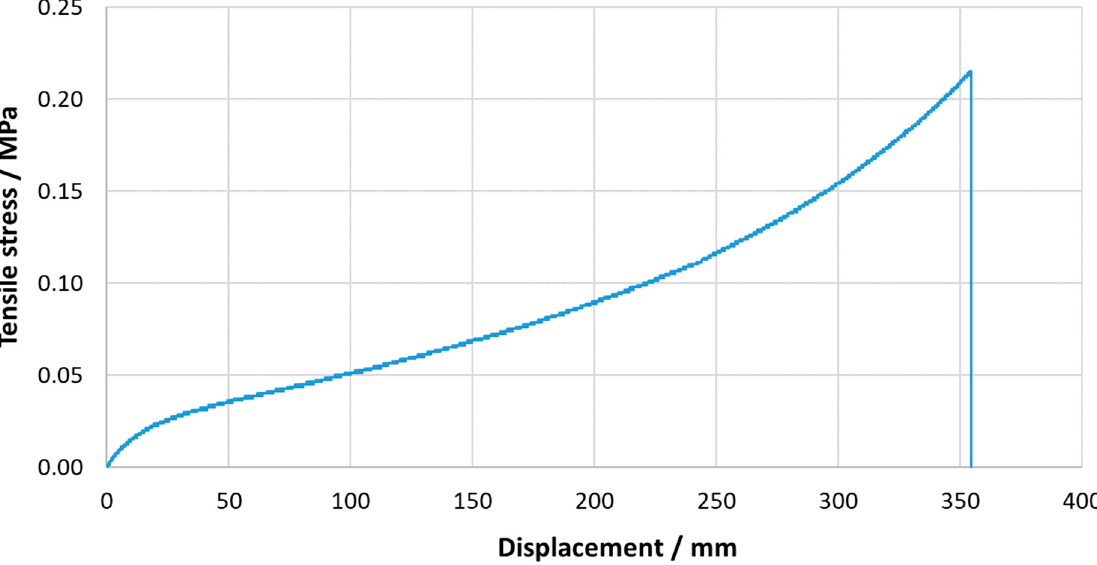
Figure 8. Tensile stress–displacement representative curve for the acrylic PSA bulk specimens.